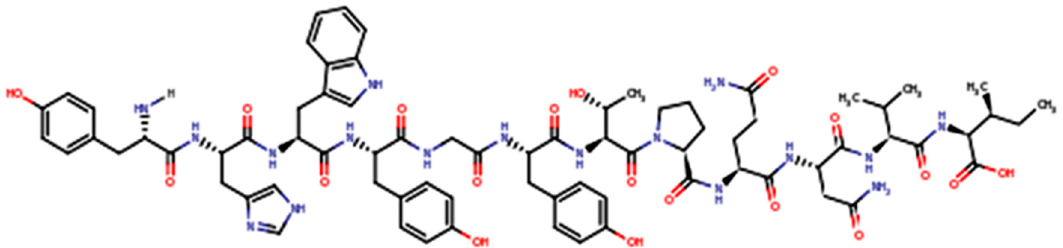
Figure 2. GE11 primary structure.